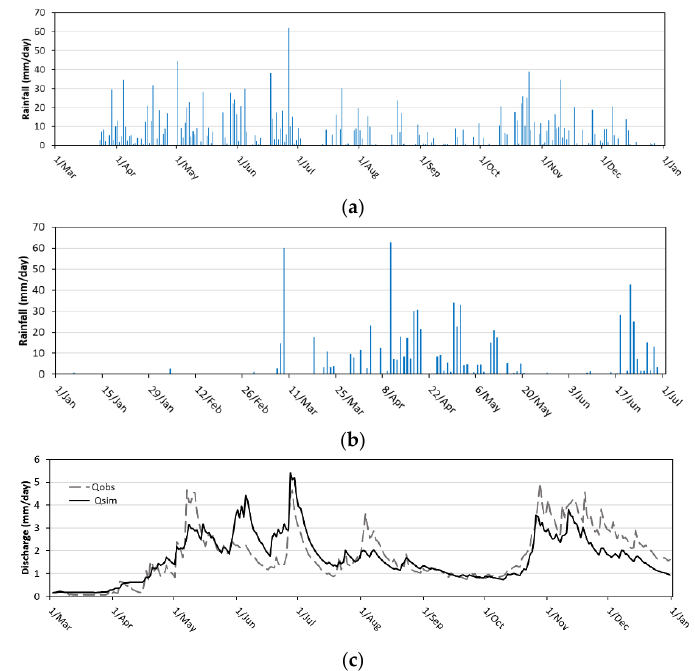
Generally, there was a similar trend between the observed and simulated hydrographs, with an observable response of the simulated hydrograph to rainfall input (refer to Figure 5).